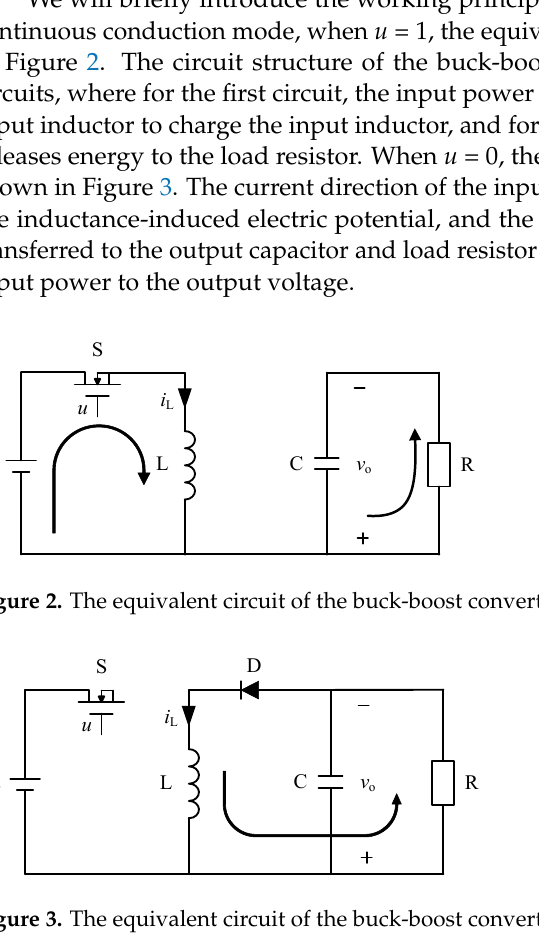
Figure 1. Circuit structure of the buck-boost converter.